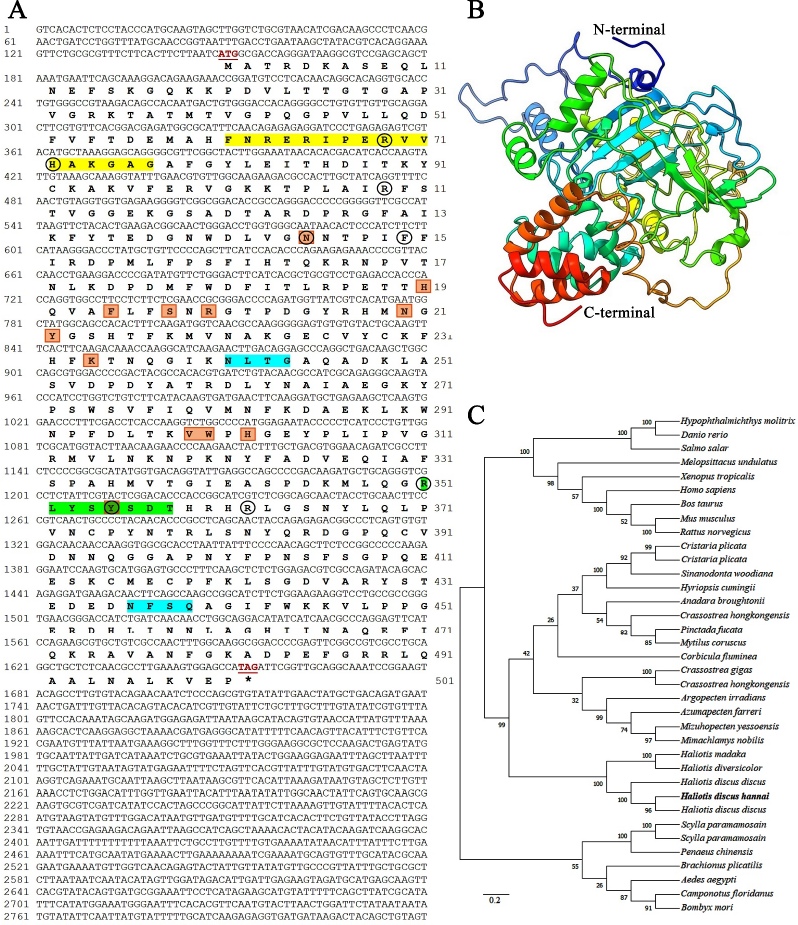
Figure 1. Sequence analysis of catalase ( Hdh-CAT ) in Pacific abalone, H. discus hannai . ( A ) The full-length nucleotide (GenBank: OK042347.1) and deduced amino acid sequences (GenBank: UFT26656.1). Numbers on the left and right columns indicate nucleotide and amino acid positions in the sequence, respectively. The initiation (ATG) and termination (TAG) codons of nucleotide sequence are marked as bold red color and underlined. The stop codon of nucleotide sequence was indicated using *. Hdh-CAT active site motif and heme-ligand signature motif are highlighted using yellow and light green colors, respectively. Heme-binding site residues are pointed using circle. Two putative N -glycosylation sites are indicated using light sky color. The putative NADPH binding residues are pointed using box. The polyadenylation signal (AATAAA) is indicated in boldface. ( B ) Three-dimensional (3D) homology modeling of Hdh-CAT. ( C ) Phylogenetic tree of catalase protein sequences from vertebrates and invertebrates. GenBank accession number of all sequences of phylo- genetic tree are as follows: Hypophthalmichthys molitrix (ADJ67807.1), Danio rerio (NP_570987.2), Salmo salar (ACN11170.1), Melopsittacus undulatus (AAO72713.1), Xenopus tropicalis (AAH90377.1), Homo sapi- ens (NP_001743.1), Bos taurus (3NWL_A), Mus musculus (P24270.4), Rattus norvegicus